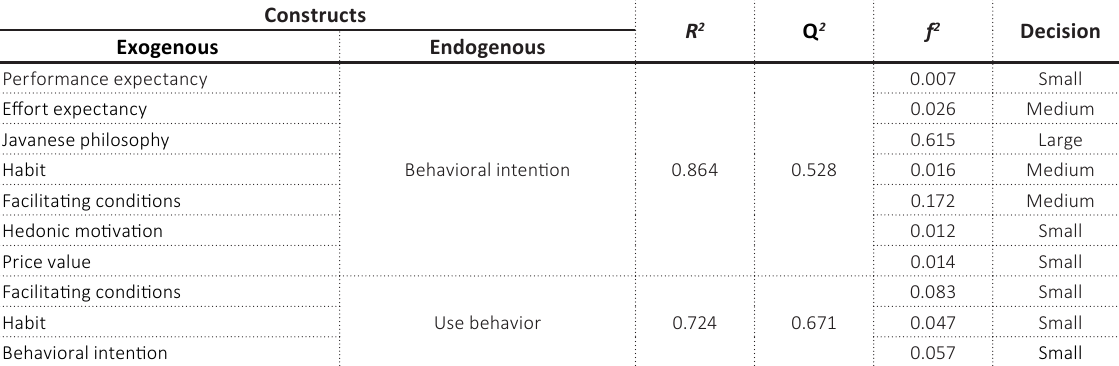
Table 6. Evaluating coefficients of R 2 , Q 2 , f 2 , and